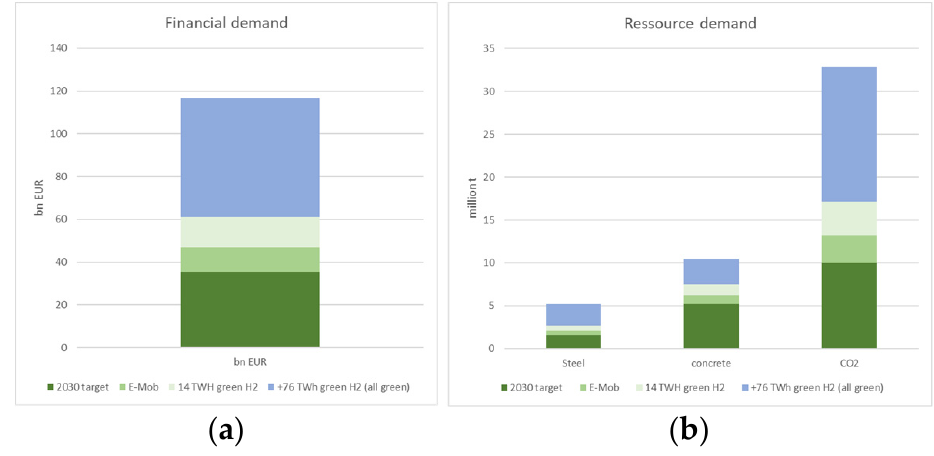
Figure 2. Financial and resource demand when using turbines of Type 2.